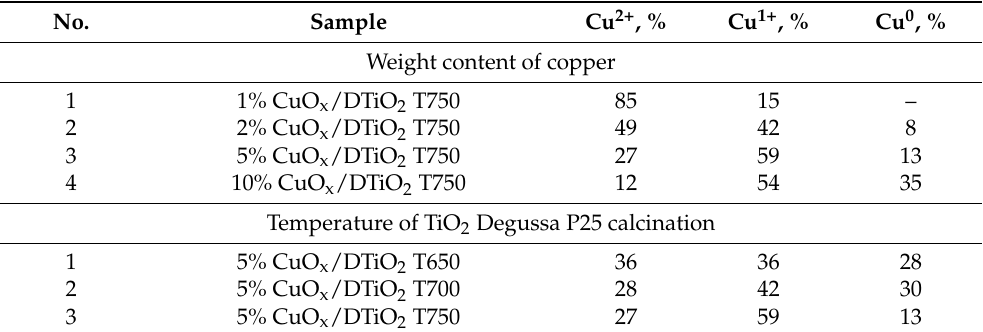
Figure 5. XANES spectra of the K-absorption edge of Cu ( a ) (1–10)% CuO x /DTiO 2 T750; ( b ) 5% CuO x /DTiO 2 T650–T750 in comparison with the spectra of metallic copper, Cu 2 O, CuO, and Cu(OH) 2 . Table 3. Phase composition of the samples according to the results of the linear combination fitting of Cu K -edge XANES